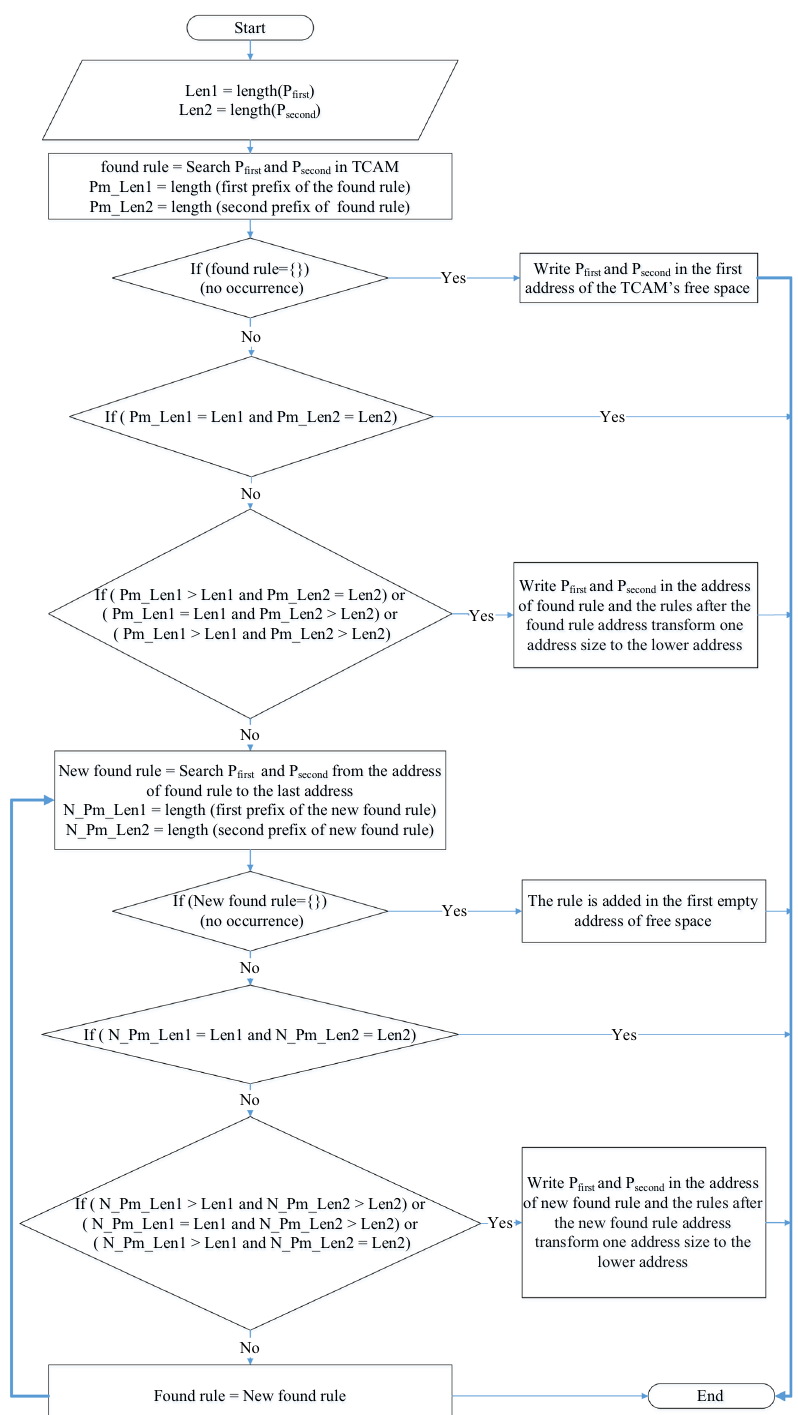
Fig. 3 The flowchart of adding rule in the first